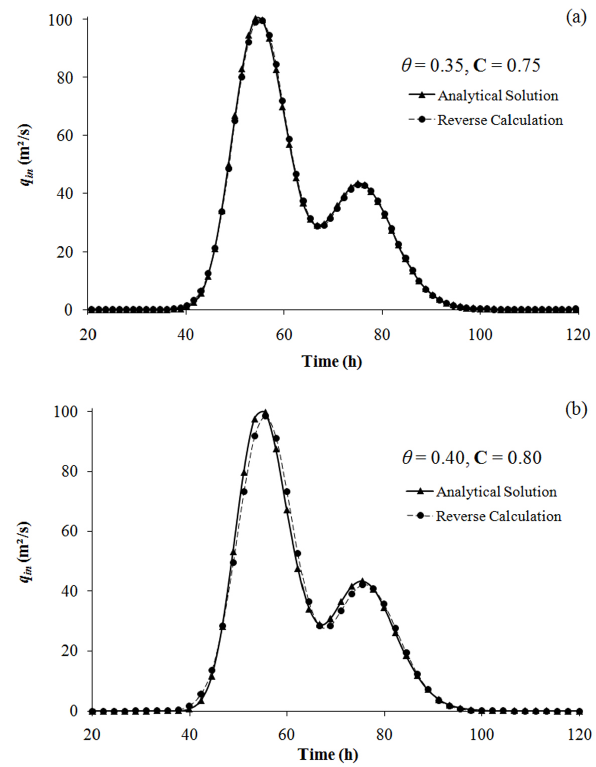
Fig. 5. Double-peak inflow hydrograph recovered through reverse routing from perfect outflow data at x = 50km with grids: C = 0 . 75, θ = 0 . 35 (near-optimal) and C = 0 . 8, θ = 0 . 4 (non-optimal); the an- alytical inflow is also shown for